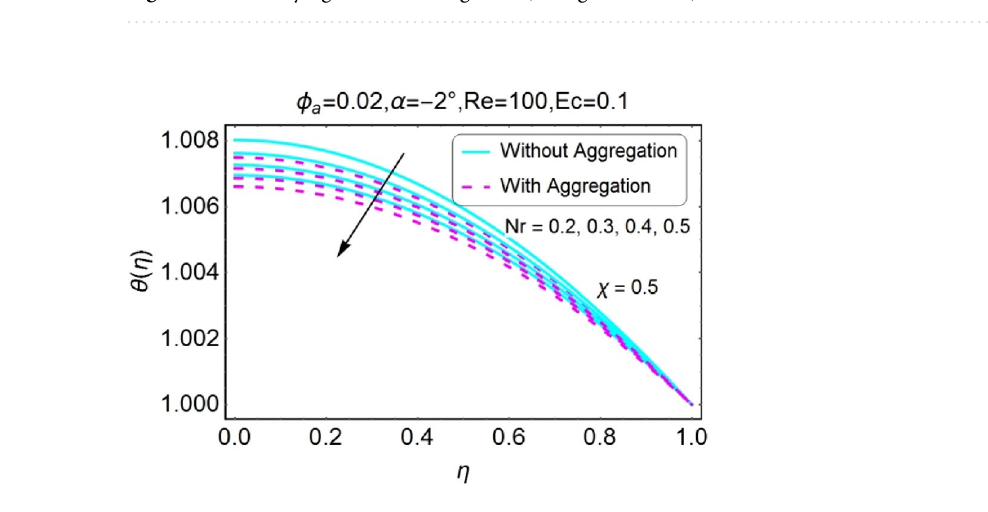
Figure 23. Nr varying θ for stretching walls (convergent channel).